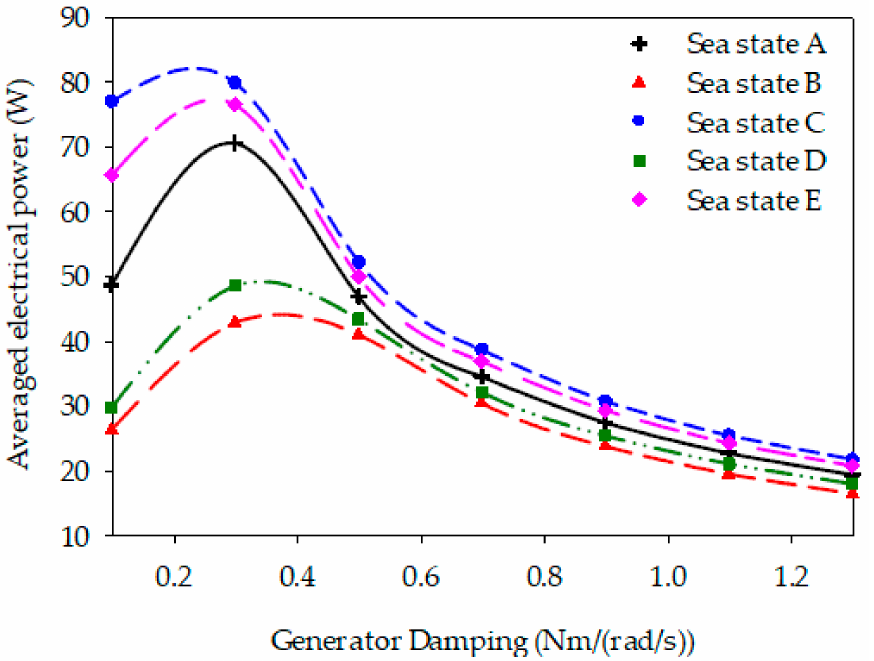
Figure 13. Averaged power of generator versus damping of generator corresponding to different sea